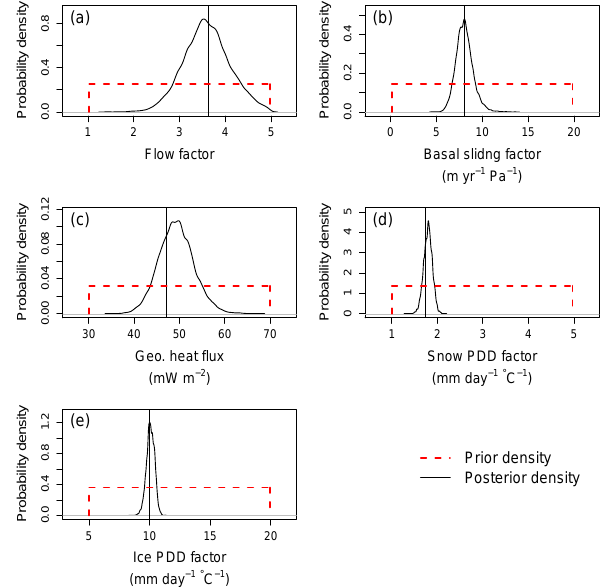
Figure 3. Prior (dashed red curves) and posterior (solid black curves) probability density functions of each input parameter, as- suming that all the other parameters are held fixed at their assumed- true values. The vertical lines indicate the assumed-true values of the individual parameters. See Fig. S2 in the Supplement for the effect of excluding the discrepancy term ( δ in Eq. 1) on the results. averaged ice thickness vectors are minor. Thus, our methods pass check no. 1,